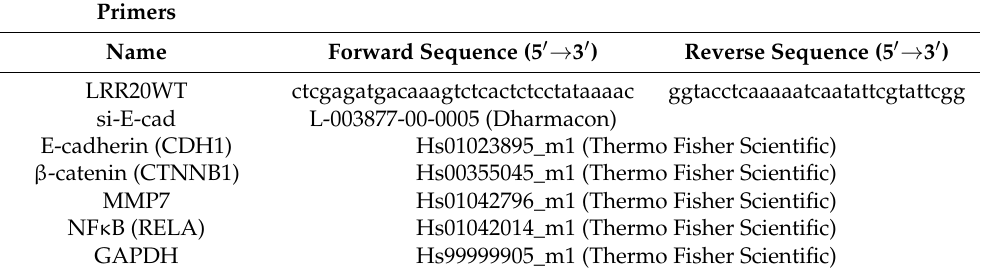
Table 1. Primers used in this